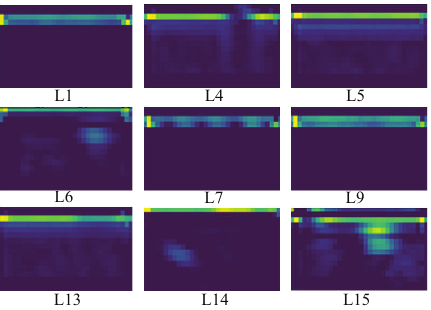
Figure 5. The output of the convolution filter when L13 is the input.